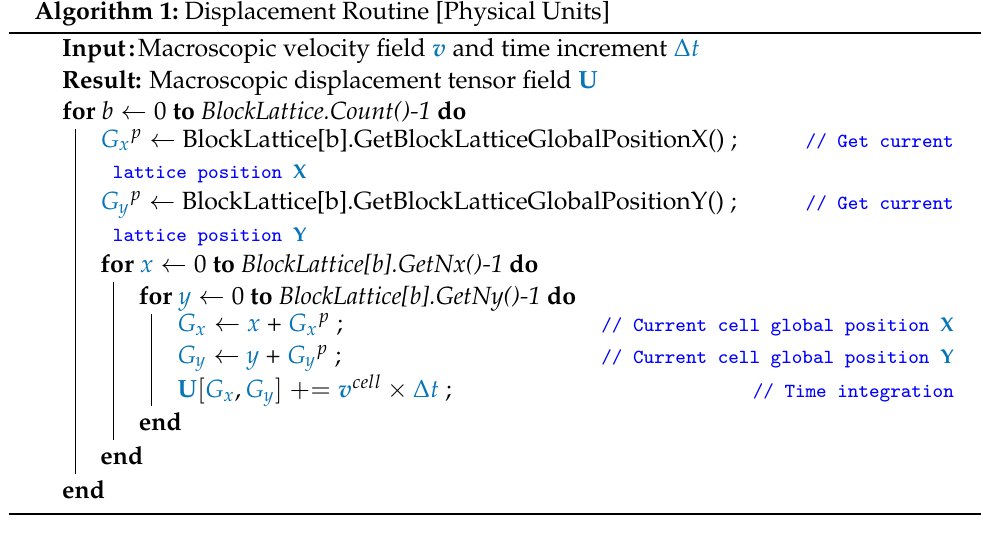
Algorithm 1: Displacement Routine [Physical Units]